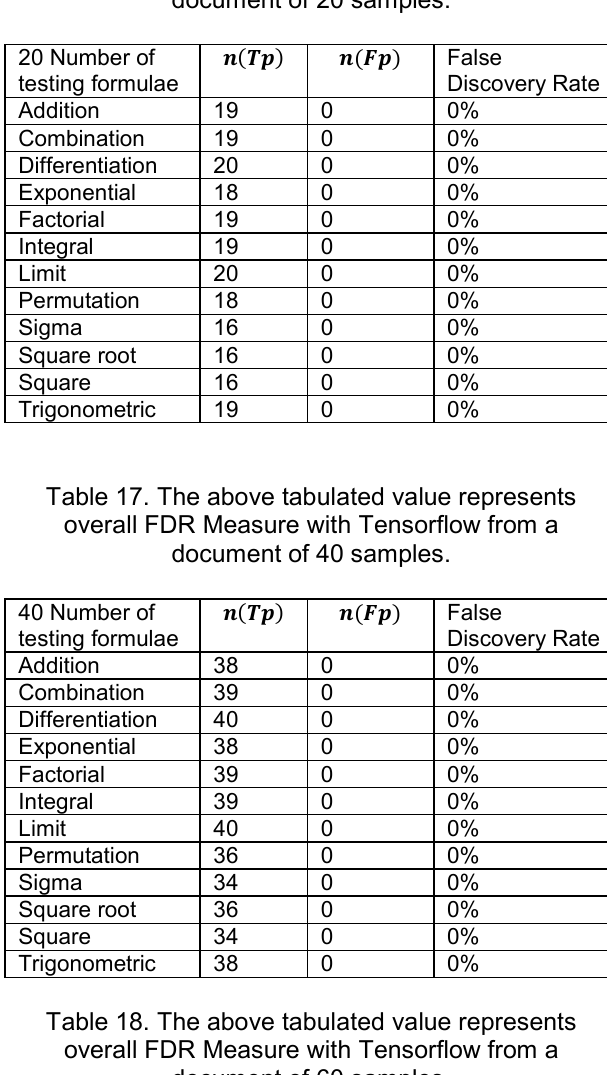
Table 16. The above tabulated value represents overall FDR Measure with Tensorflow from a document of 20 samples.